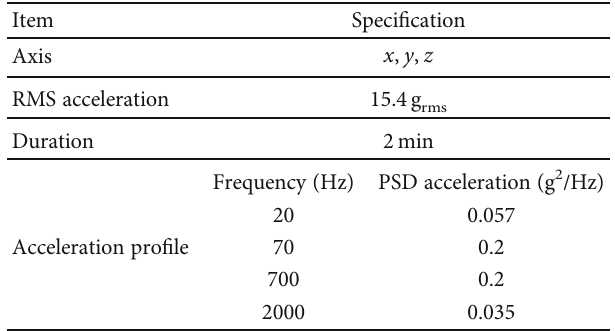
Table 3: Speci fi cation of random vibration